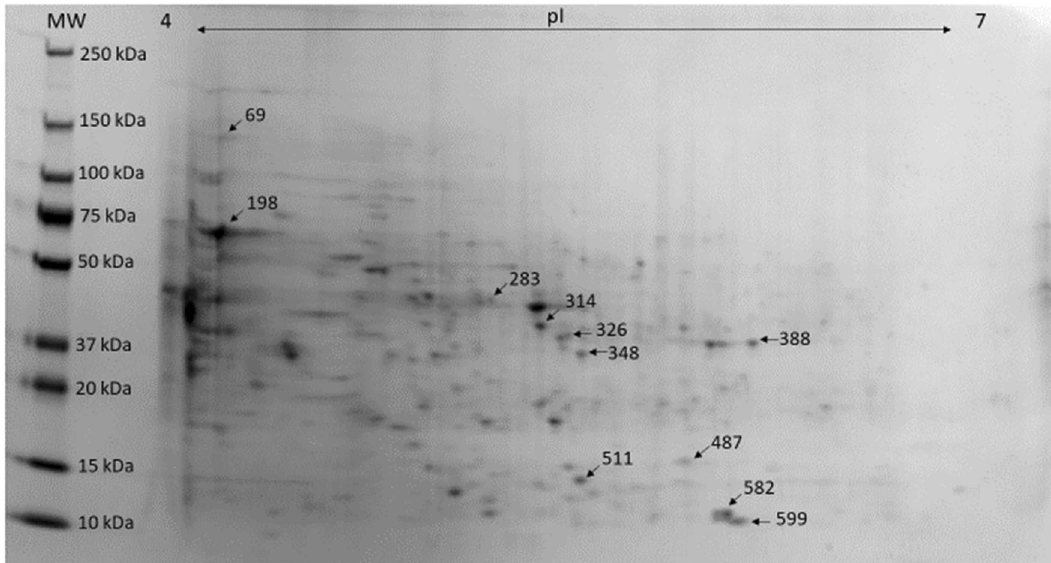
Figure 3:. 2D gel of the reference gel from the newly acquired culture of N. perurans . 11 spots displayed differential expression and were excised for LC MS/MS.